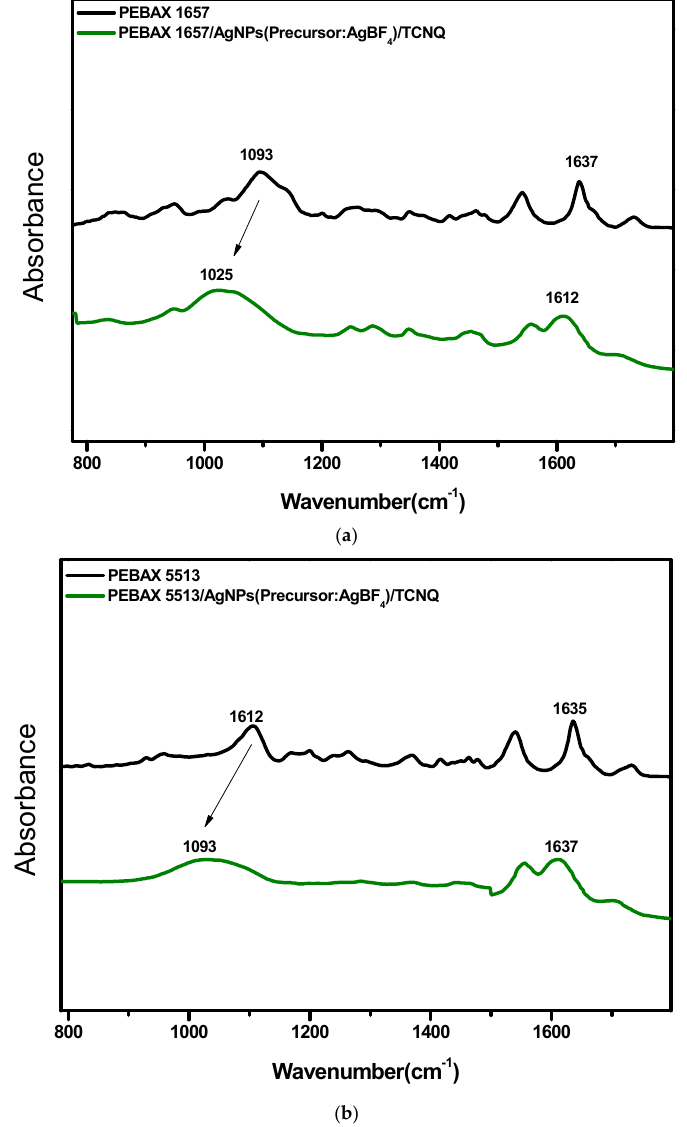
Figure 4. FT-IR spectra for polyether group of ( a ) PEBAX-1657 and PEBAX-1657/AgNPs, ( b ) PEBAX- 5513 and PEBAX-5513/AgNPs.